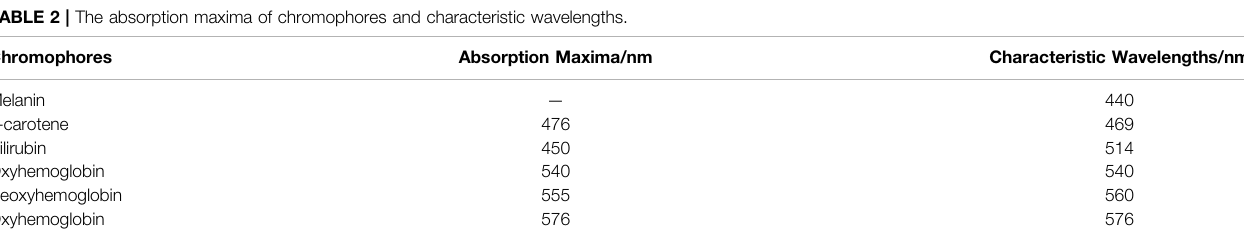
TABLE 2 | The absorption maxima of chromophores and characteristic wavelengths.